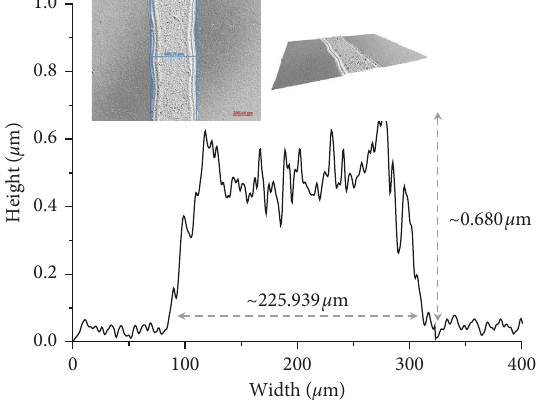
Figure 12: The height-width diagram of section of line after printed. Inset shows the micrograph of the respective line taken by Sensofar Metrology 3D microscope